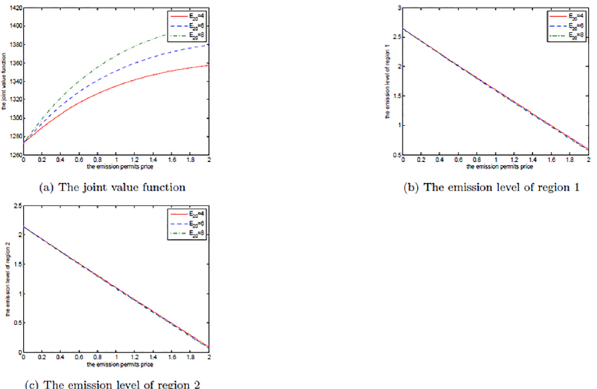
Fig 18. The effects of E 20 on the cooperative